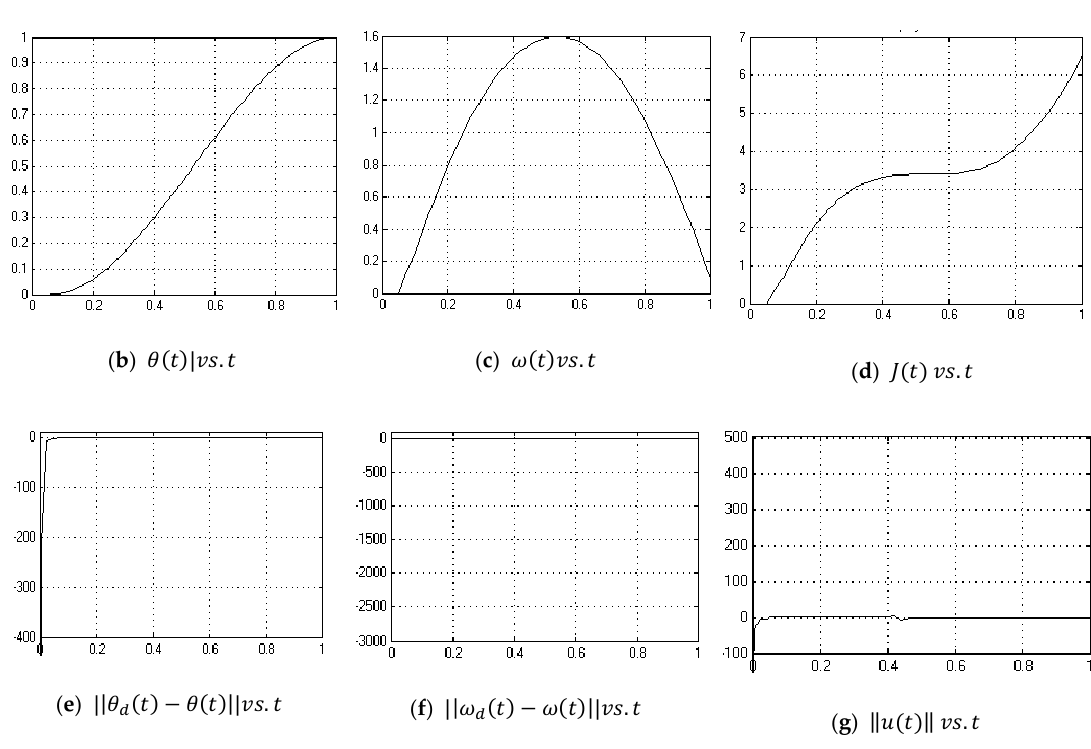
Figure A11. Sampled predictive controlled simulation.